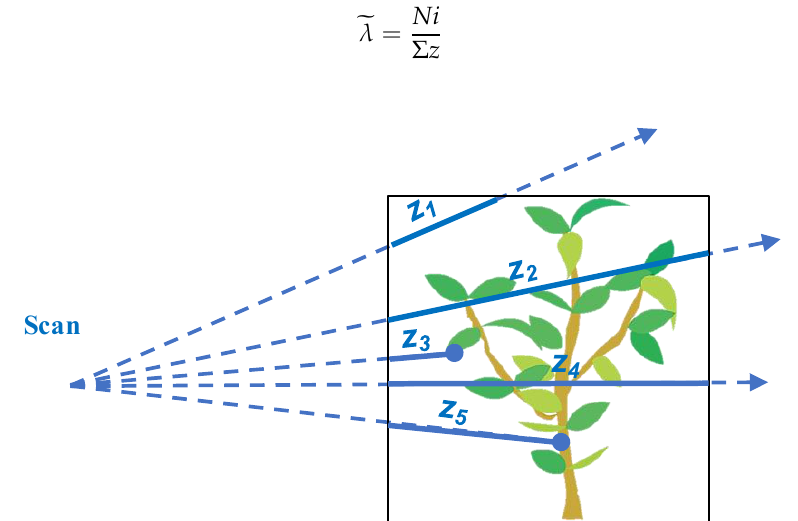
Figure 1. Scheme of the information provided by the traversal algorithm which is used to compute the MLE of the attenuation coefficient: number of hits Ni (blue dots) and free paths (distances z travelled by the beams; blue lines) in each voxel. The dotted lines represent pulse trajectory.